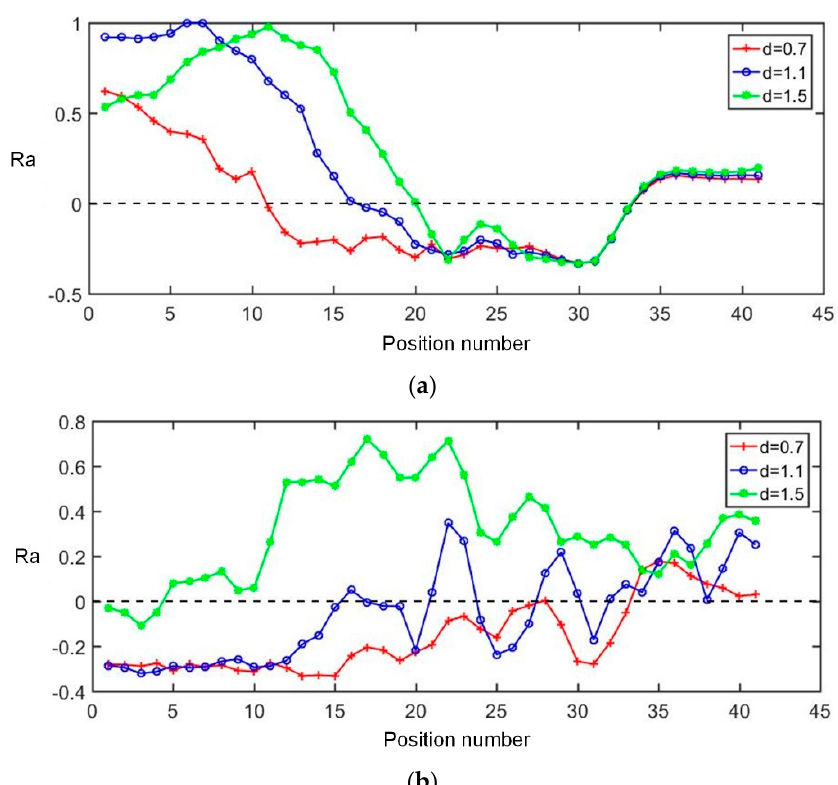
Figure 10. The evolutions of Ra with respect to the inclusion positions based on ( a ) focusing sensor and ( b ) uniform sensor.